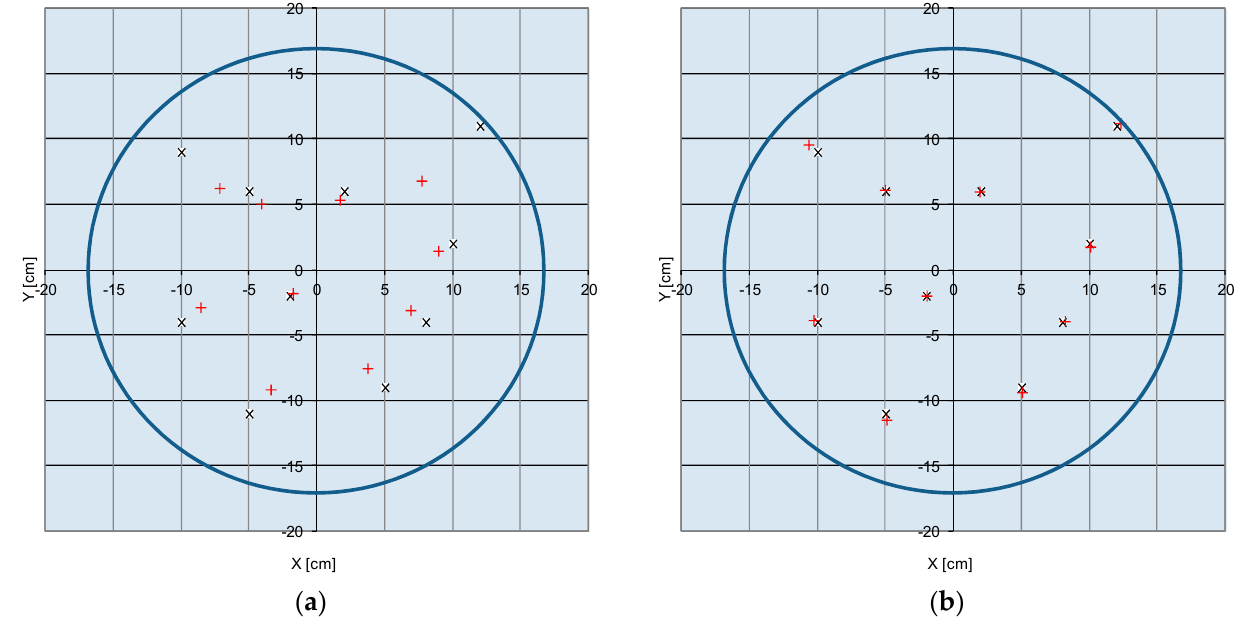
Figure 9. The figure shows the effect of individual location algorithms. The actual location of the signal source is marked with “x”, and the place indicated using the standard ( a ) or corrected ( b ) algorithm with “+”. The circle indicates the assumed maximum area available during the test (diameter 17 cm).